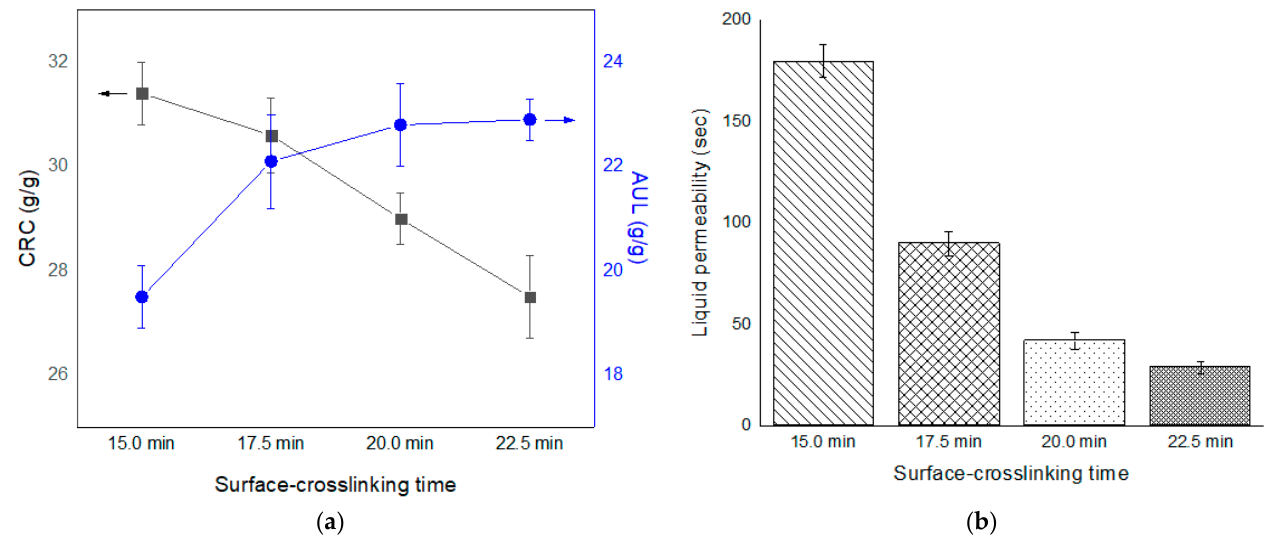
Figure 6. CRC and AUL ( a ) and permeability ( b ) of the SSAP according to surface-crosslinking time.